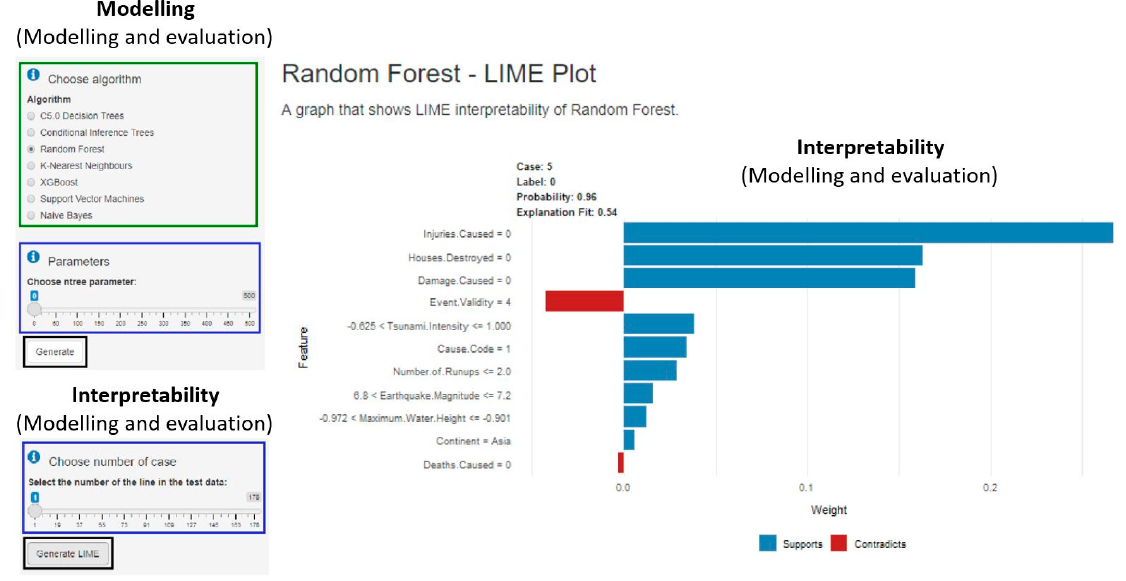
Information 2023 , 14 , x FOR PEER REVIEW